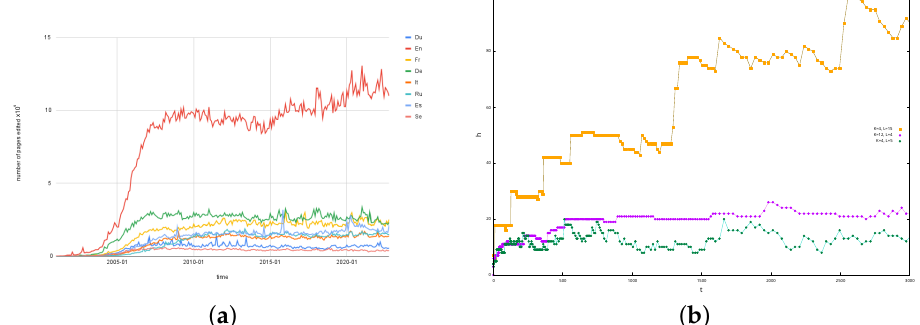
Figure 11. ( a ) Number of pages edited by users in hundreds of thousands (10 5 ), excluding redirect pages of some of the biggest Wikipedia editions. Codes: Du = Dutch, En = English, Fr = French, De = German, It = Italian, Ru = Russian, Es = Spanish, Se = Swedish. Data collected from [33]. ( b ) Zoom of the first part of Figure 6, where for L = 15 the trend has not stabilized